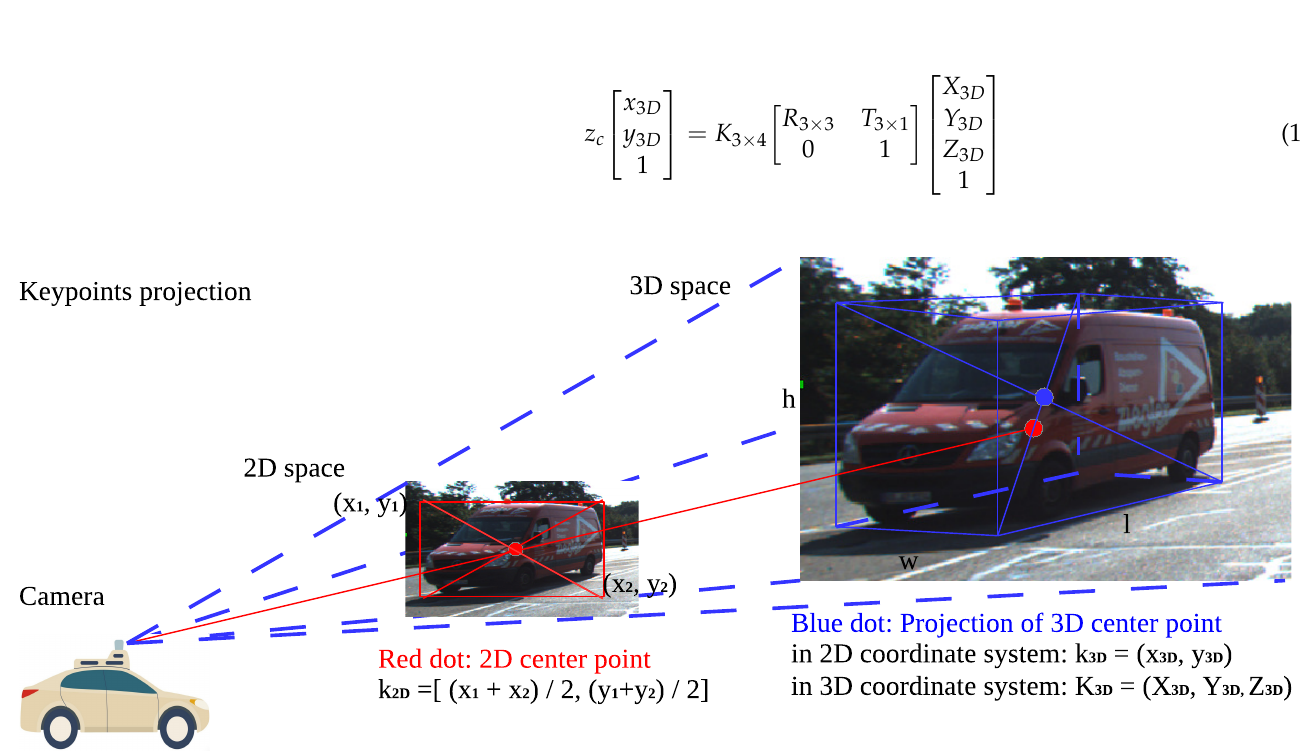
Figure 2. Keypoints mapping from 3D to 2D space. The red and blue dots denote the 2D center point and the projected keypoint from 3D space,